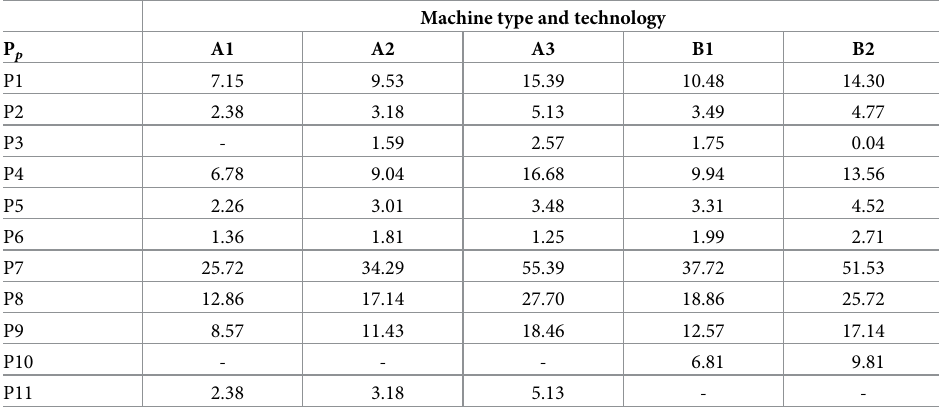
Table 9. Laser cutting speeds for each technology obtained from Eq 4 in